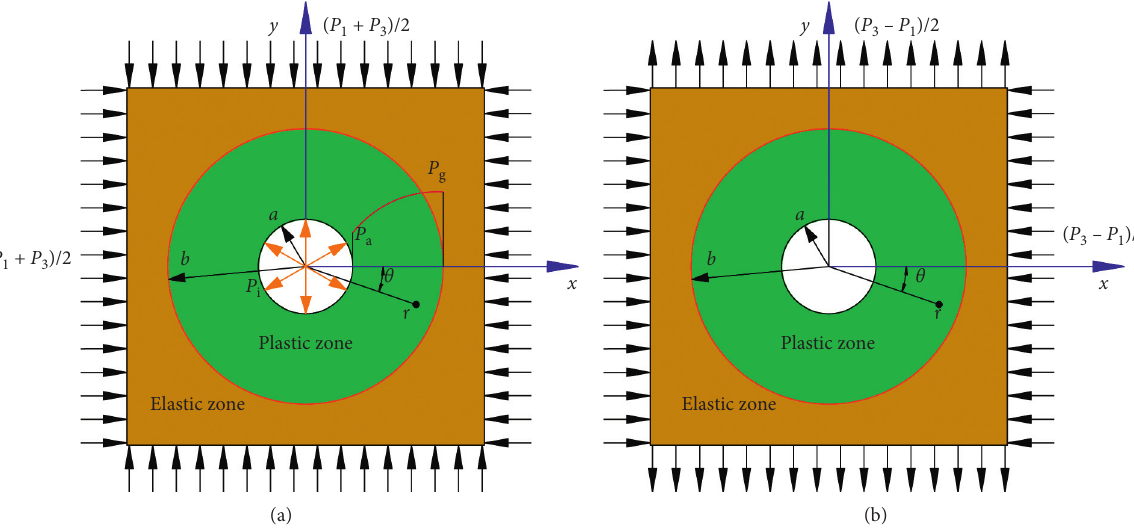
Figure 2: Decomposition of surrounding rock pressure for